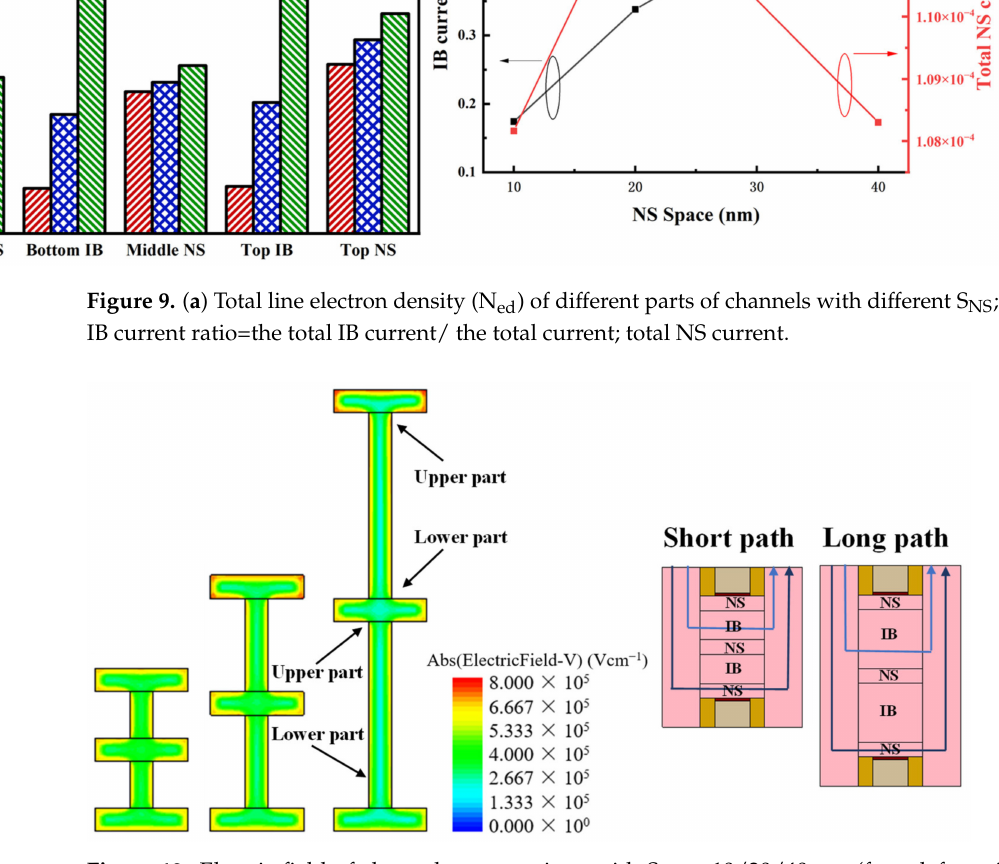
Figure 10. Electric field of channel cross sections with S NS = 10/20/40 nm (from left to right) at W IB = 5 nm and V GS = V DS = 0.7 V. The inset shows the short and long carrier paths at different S NS ,